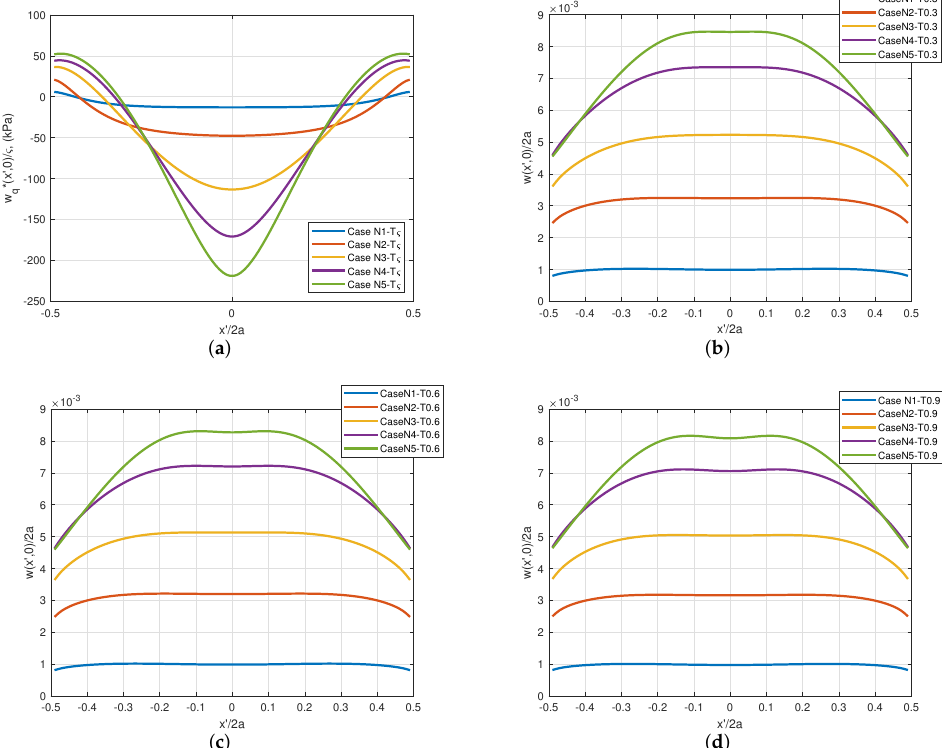
Figure 11. Effects of tangential contact traction on total vertical displacement. ( a ) Normalized compo- nent of vertical displacement due to the tangential traction components alone (from Equation (7)). ( b ) Resulting displacements from combined normal and tangential loading cases when ς = 0.3; ( c ) ς = 0.6; and ( d ) ς = 0.9. Values of E = 9806.65 kPa and ν = 0.4 were chosen for the combined load displacement influences in ( b – d